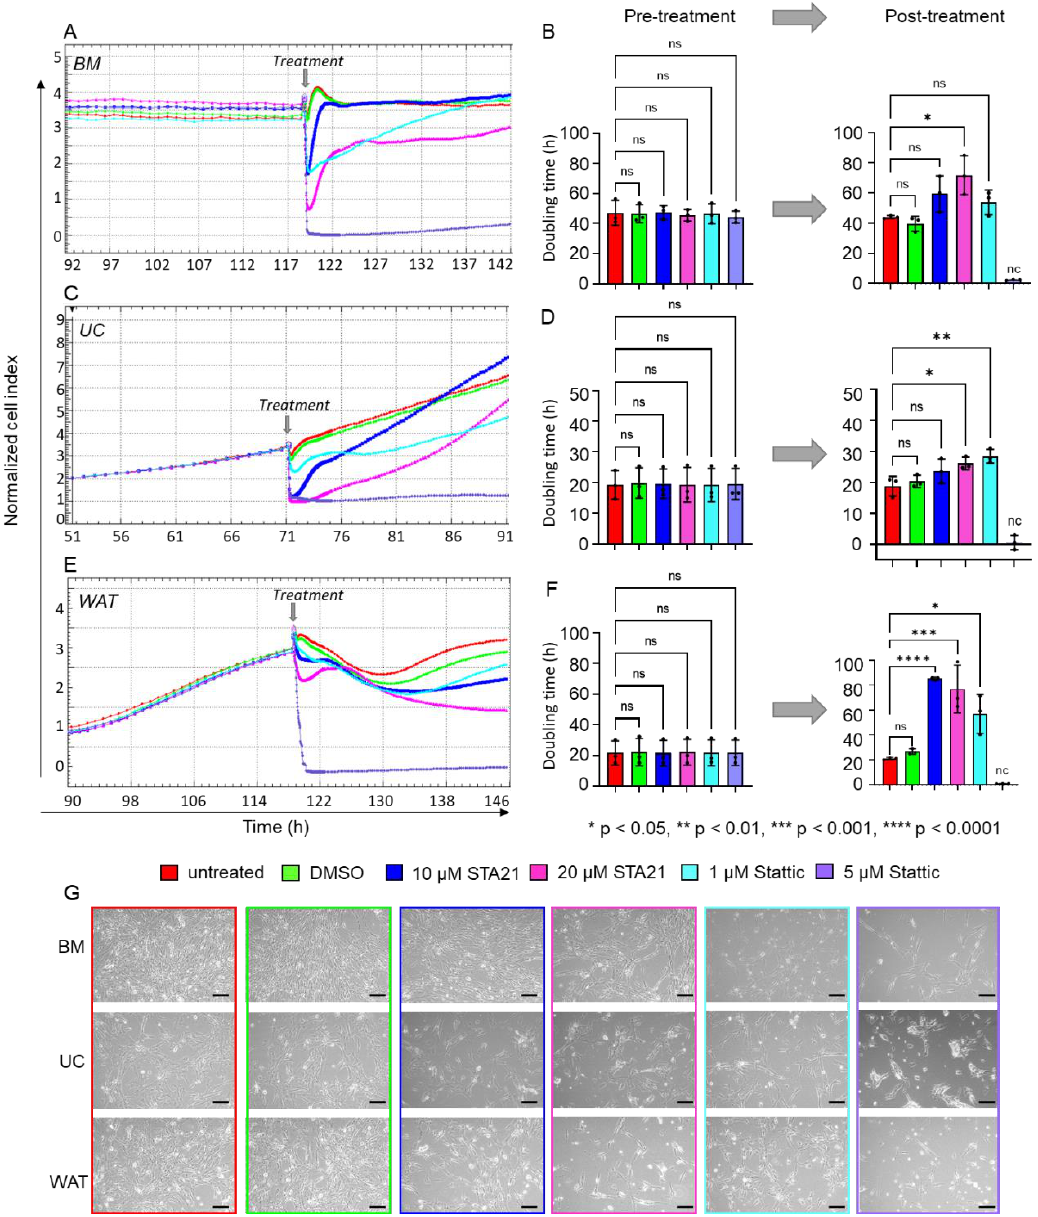
Figure 5. Specific inhibition of STAT3 significantly decreased HPL-mediated proliferation of stromal cells. xCELLigence impedance measurements of ( A ) BM-, ( C ) UC- and ( E ) WAT-derived stromal cells. Treatment with the specific STAT3 inhibitors STA21 and Stattic was carried out at two different concentrations (treatment times indicated as grey arrow). Our data revealed substantially reduced cell proliferation after the treatment with both lower (10 µM STA21 in blue, 1 µM Stattic in cyan) and higher (20 µM STA21 in magenta, 5 µM Stattic in violet) concentrations. Untreated (red) cells or stromal cells treated with DMSO only (green) served as control. Data shown are xCELLigence impedance measurements depicted as mean normalized cell index over time of one representative cell donor for each source measured in technical quadruplicates. ( B , D , F ) The doubling time in hours (h) was calculated for each stromal cell type before and 24 h after the treatment. Data shown are mean doubling time values ± SD, given in hours, of three biological replicates measured in technical quadruplicates; nc = not calculable, ns = not significant. ( G ) Cell morphology was documented 8 h after the treatment with the inhibitor and respective concentration as indicated. One representative is shown for each stromal cell type. Scale bar = 200 µ